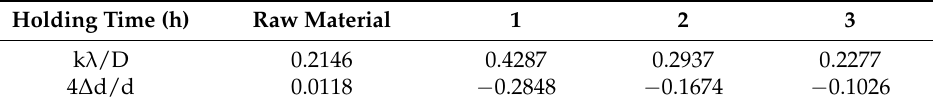
Table 4. Relation between Bcos θ and sin θ of sericite with different holding